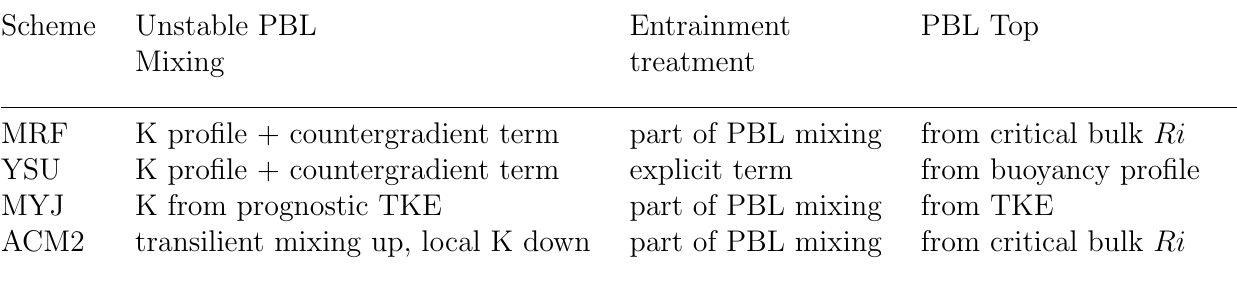
Table 8.4: Planetary Boundary Layer